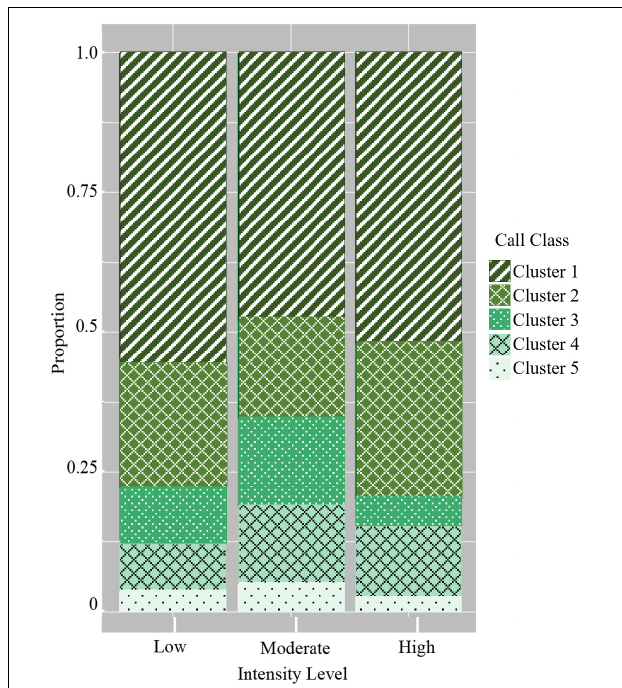
FIGURE 6 | Probability of detecting the five graded call classes in the three intensity levels. Cluster 1: Low-frequency/moderate duration; Cluster 2: Mid-frequency/long duration; Cluster 3: Broadband/very long duration; Cluster 4: High-frequency/short duration; and Cluster 5: Very high-frequency/short duration.